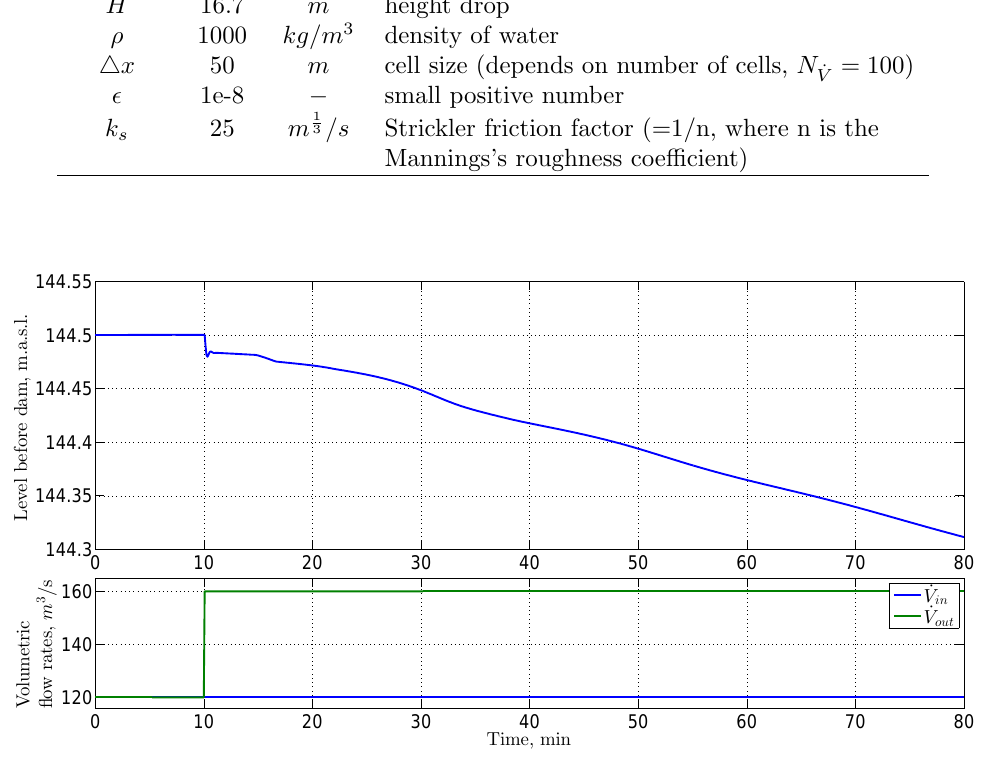
Figure 2: The step test for the outlet flow rate as the control signal.